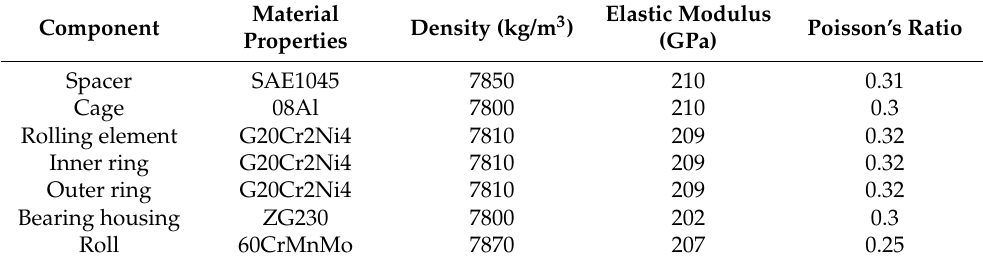
Table 2. Material parameters of the RBBH